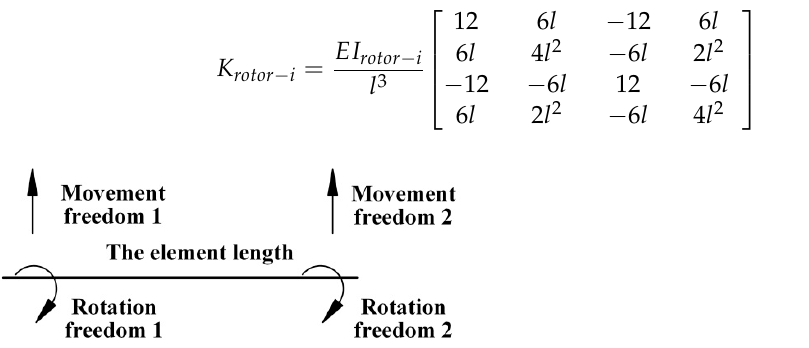
Figure 5. Any element in a